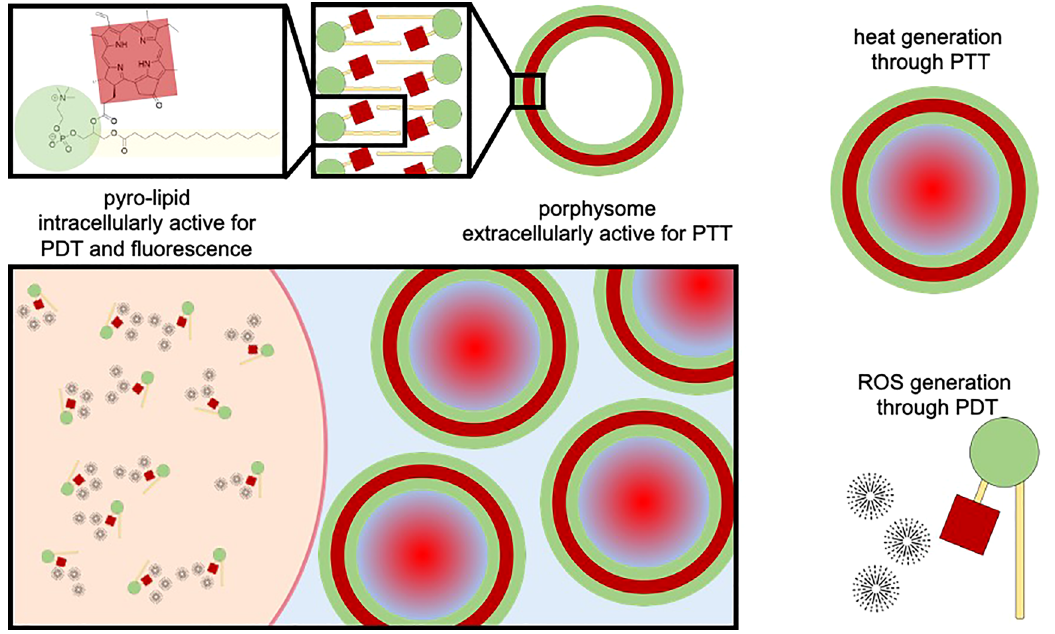
Figure 1: Schematic diagram of the distribution and activity of porphysome nanoparticles and dissociated pyro-lipid in the tumor. When irradiated with 671 nm light, the intact porphysomes in the extracellular space respond photothermally (lower panel, right), while the disrupted intracellular porphysomes (pyro-lipid) are unquenched and generate reactive oxygen species (ROS; e.g., 1 O 2 ) for photodynamic therapy (lower panel,